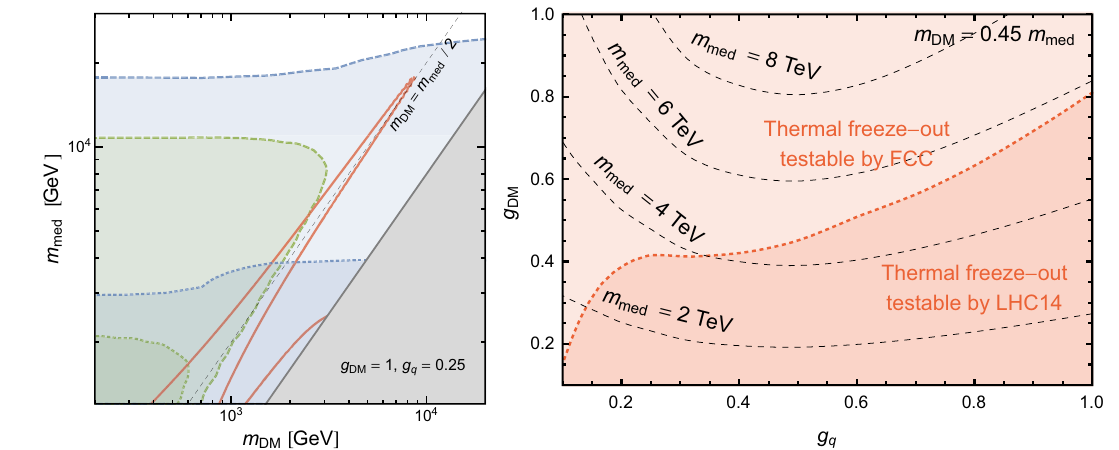
Fig. 12.4 Left: expected sensitivity of monojet (green) and dijet res- onance (blue) searches at the 100 TeV collider (dashed lines) com- pared to the expected sensitivity of the LHC at 14 TeV (dotted lines) and the parameter values that reproduce the observed relic abundance (red, solid). The grey regions are excluded by perturbative unitarity (cf. [343]). Right: expected sensitivity at a 100 TeV collider (dashed)